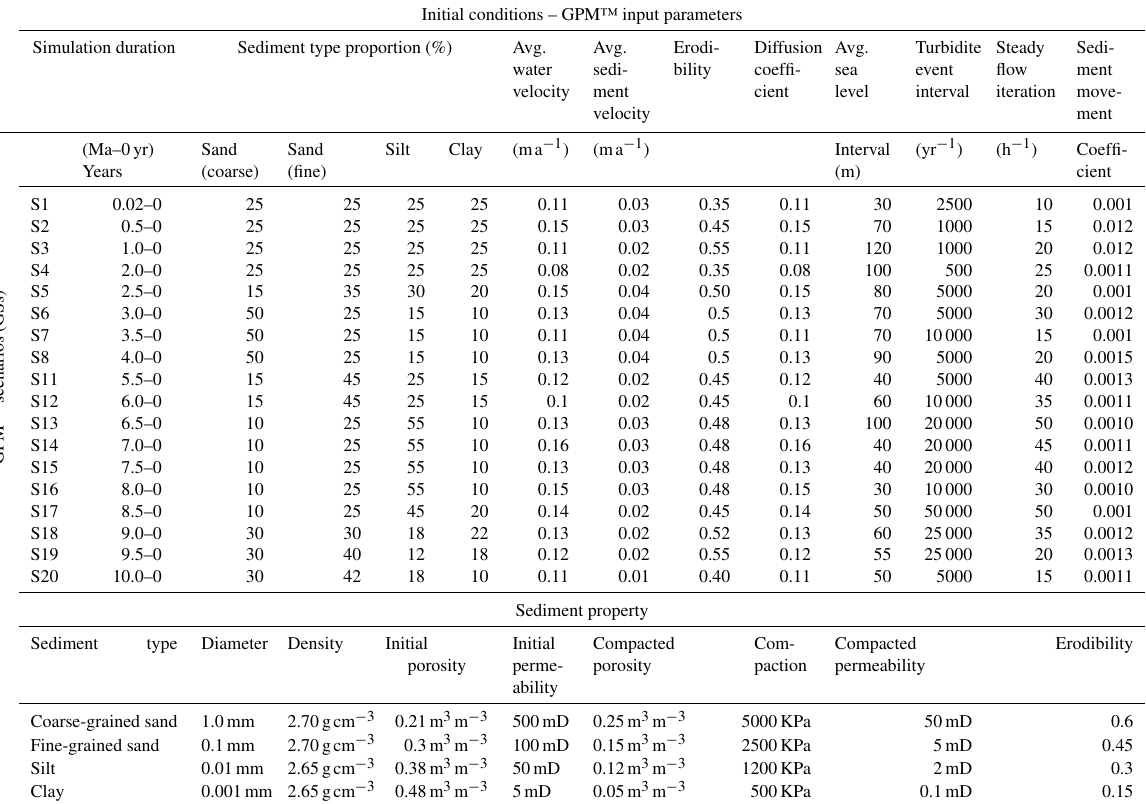
Table 2. Summarized input parameters for forward stratigraphic simulations in